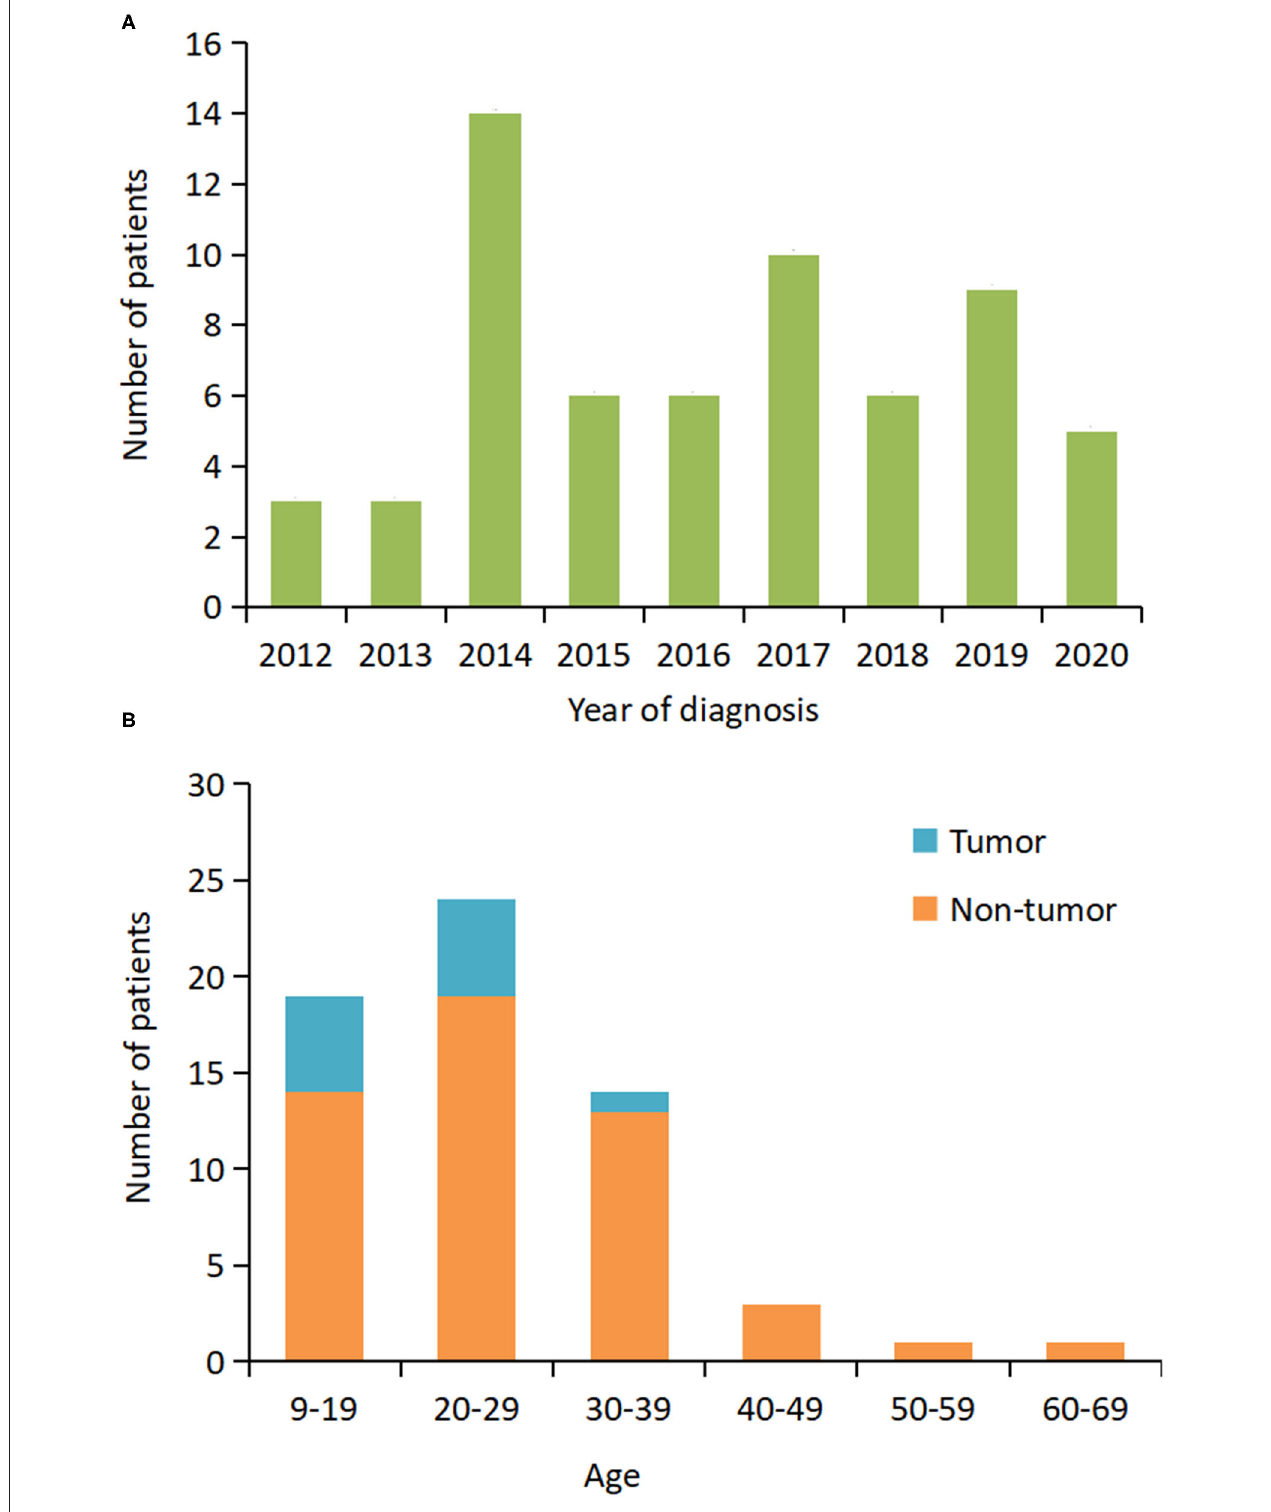
FIGURE 1 | Distribution of patients who required mechanical ventilation based on the year of diagnosis and age. (A) The number of patients at the initial hospital visit from 2012 to 2020. (B) The number of patients by age and presence or absence of the tumor.